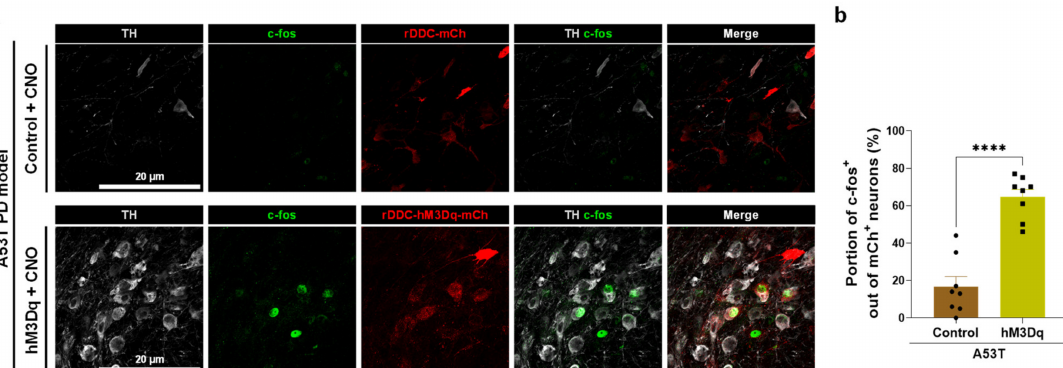
Figure 5. Chemogenetic activation of DDC + neurons increases c-Fos expression in DAergic neurons of the A53T rat model. ( a ) Representative confocal images of SNpc, which were immunolabeled with anti-TH and anti-c-fos antibodies. Scale bar = 20 µ m; ( b ) The proportion of c-fos + neurons in Rat SNpc (Control, n = 8 rats; hM3Dq, n = 8 rats). The data are presented as the mean ± SEM. The data normality was assessed by Shapiro–Wilk normality test. Statistical significance was calculated by the two-tailed unpaired Student’s t -test. The significance levels are represented as asterisks (**** p < 0.0001).